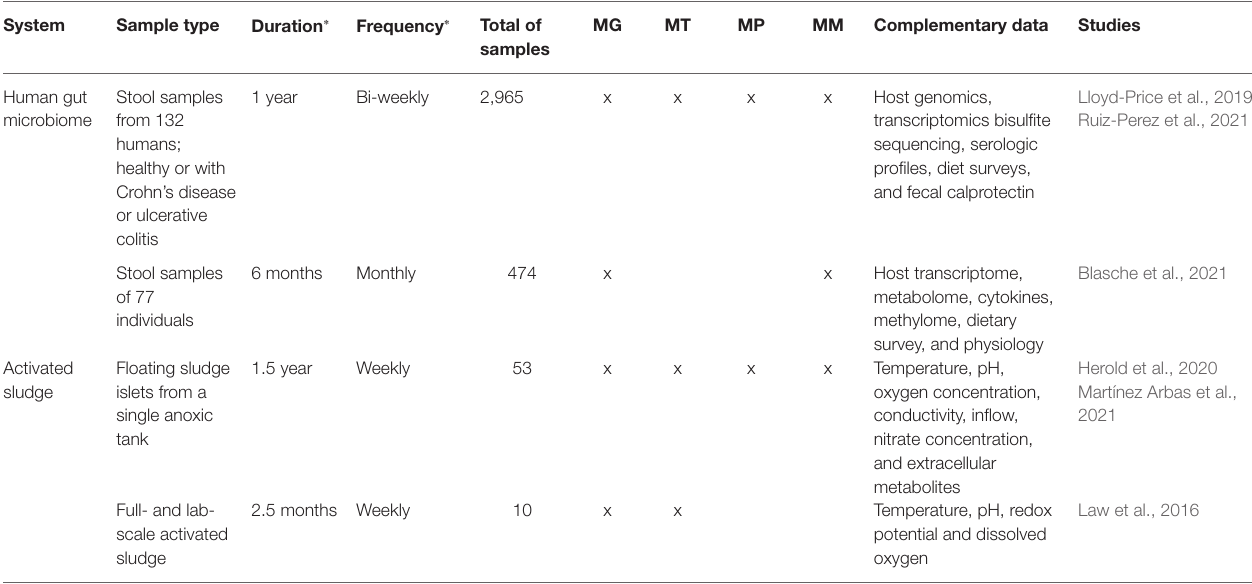
TABLE 1 | Longitudinal multi-omic microbiome datasets and